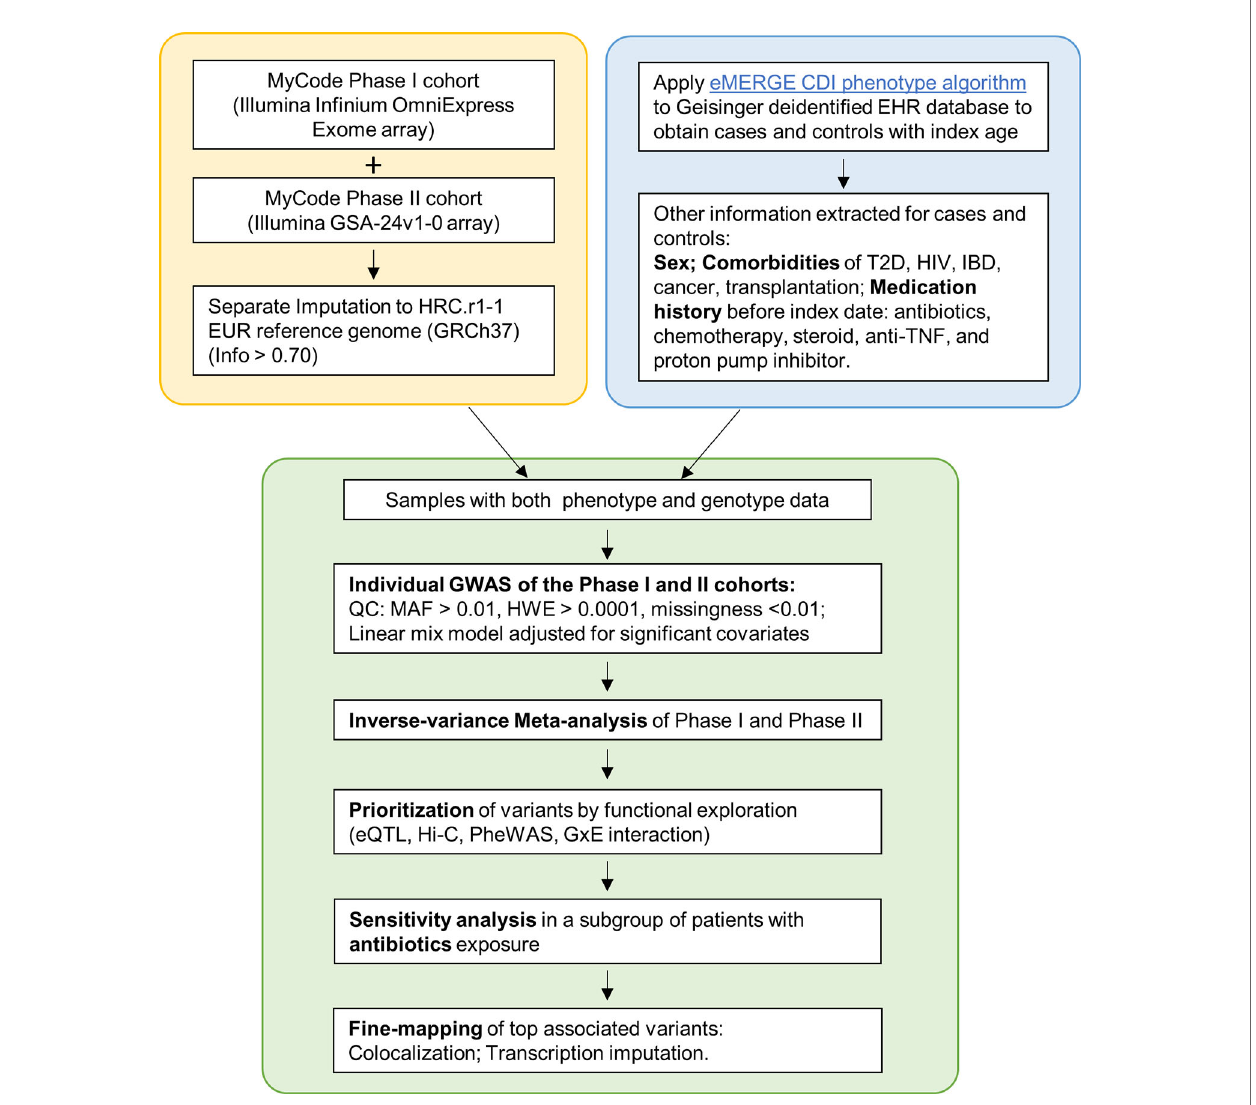
FIGURE 1 | Flowchart of the study. Yellow box: Genotyping and imputation was conducted separately for Phase I and II. Blue box: eMERGE CDI algorithm was applied to identify cases and controls. Clinical information was extracted. Green box: individual GWAS and meta-analyses, followed by a sensitivity analysis and